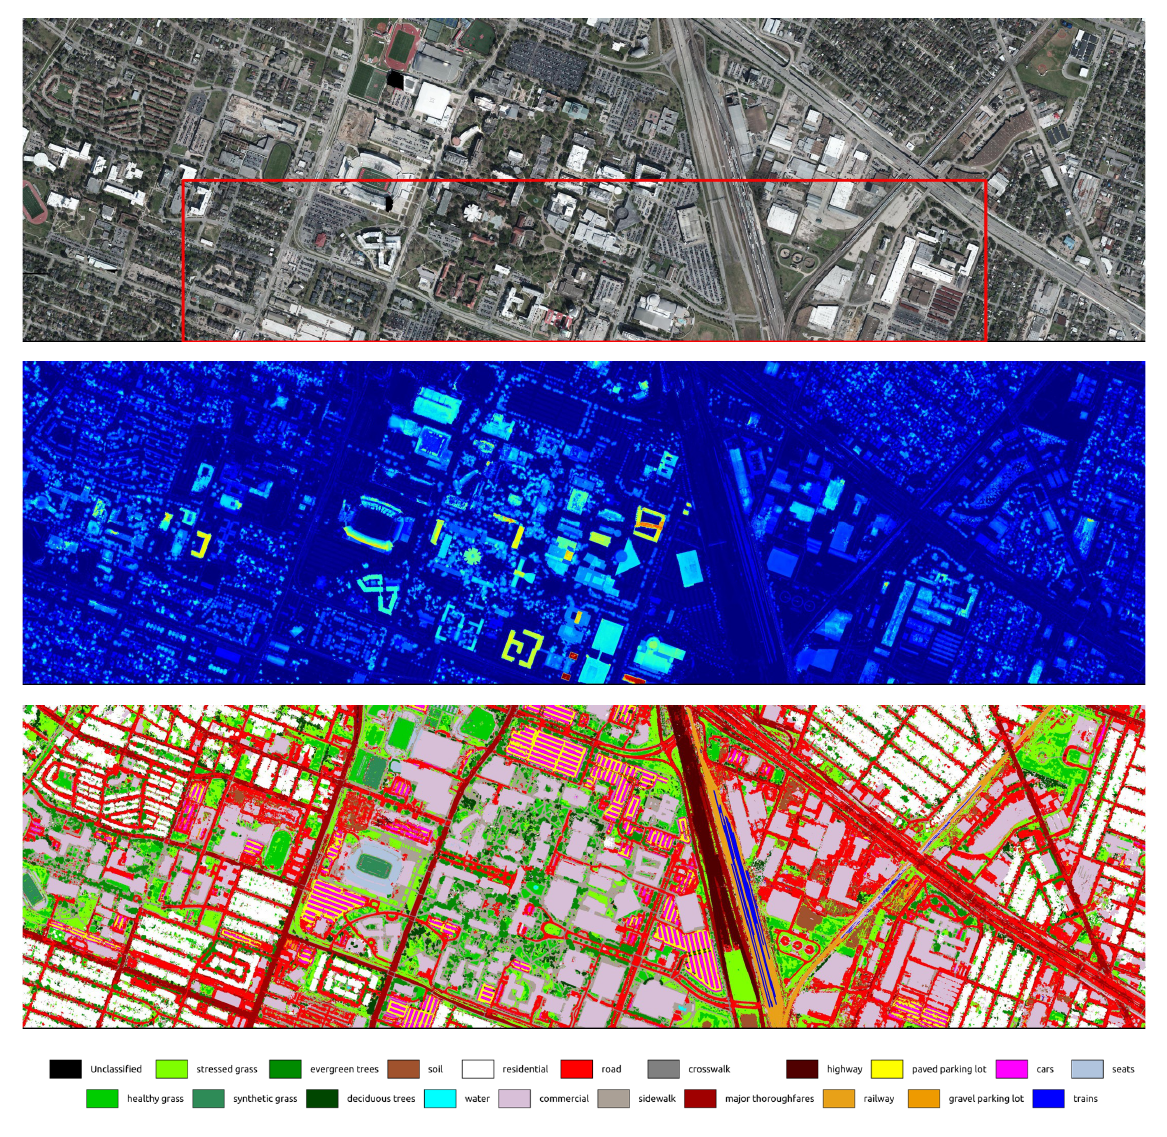
Figure 13. DFC2018 dataset inference